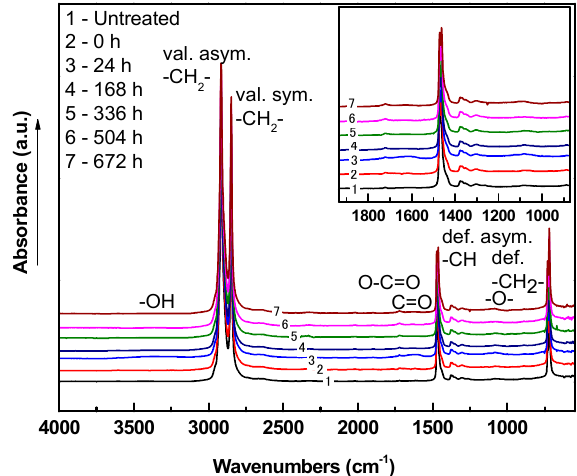
Figure 16. FTIR spectra of LDPE plasma treated for 120 s using nitrogen and stored in air.